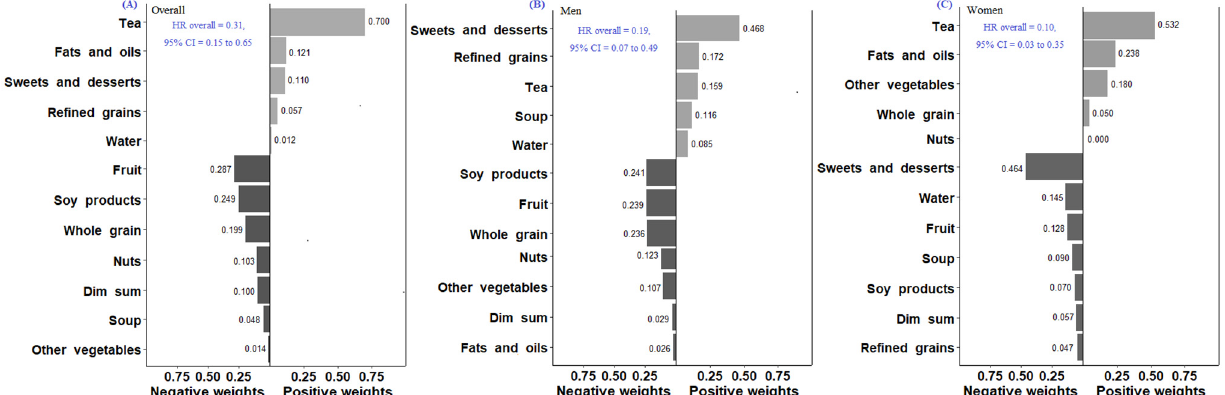
Figure 3. Weights representing the proportion of the positive or negative partial effects of each food group on cancer-mortality risk in the Quantile G-Computation Overall ( A ), Men ( B ), and Women ( C ). Model adjusted for sex, age, dietary energy, body mass index, physical activity, systolic blood pressure, medical history (diabetes, hypertension, stroke, heart attack, angina, congestive heart failure or cancer), smoking habits, alcohol drinking, and education level. Table 4. Prospective association of the quartile (Q) of food groups with cancer mortality selected by Elastic net regression among participants in the Mr. OS and Ms. OS Study.